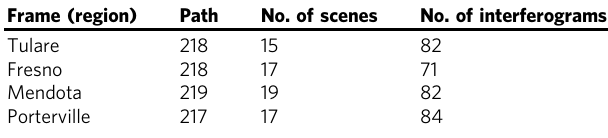
Table 1 Summary of scenes used for InSAR processing Frame